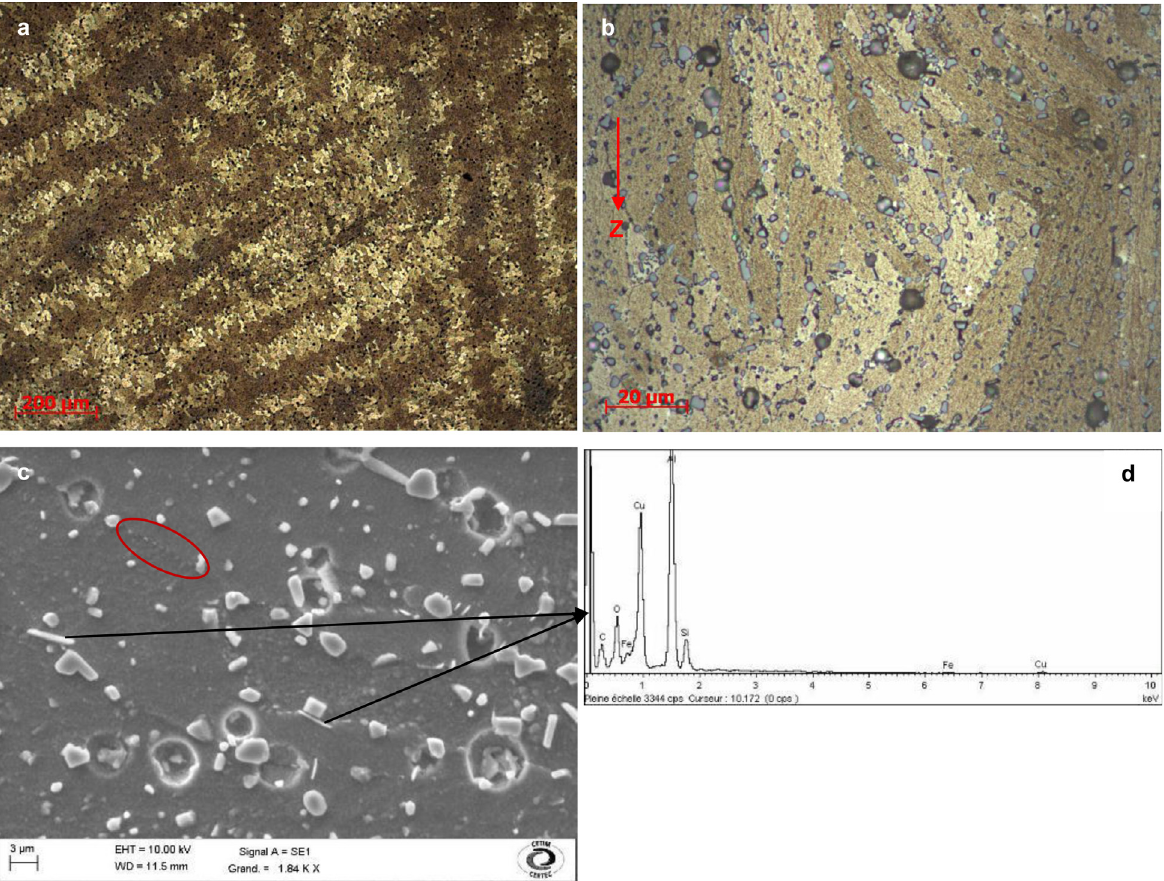
Fig. 4. AlSi5Cu3Mg alloy, T6 temper. (a) Micrographic examination in the XY plane after etching; (b) Micrographic examination along the Z direction after etching; (c) FEG-SEM examinations (secondary electron mode); (d) EDS analysis, chemical element identi fi cation